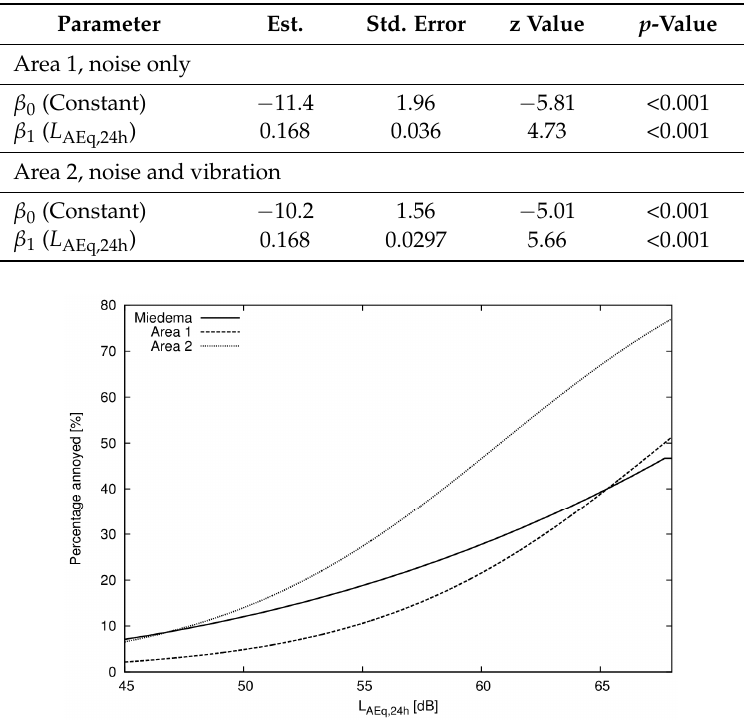
Table 3. Results from logistic regression with annoyance from noise as the outcome (area 1, noise only; and area 2, noise and vibration).